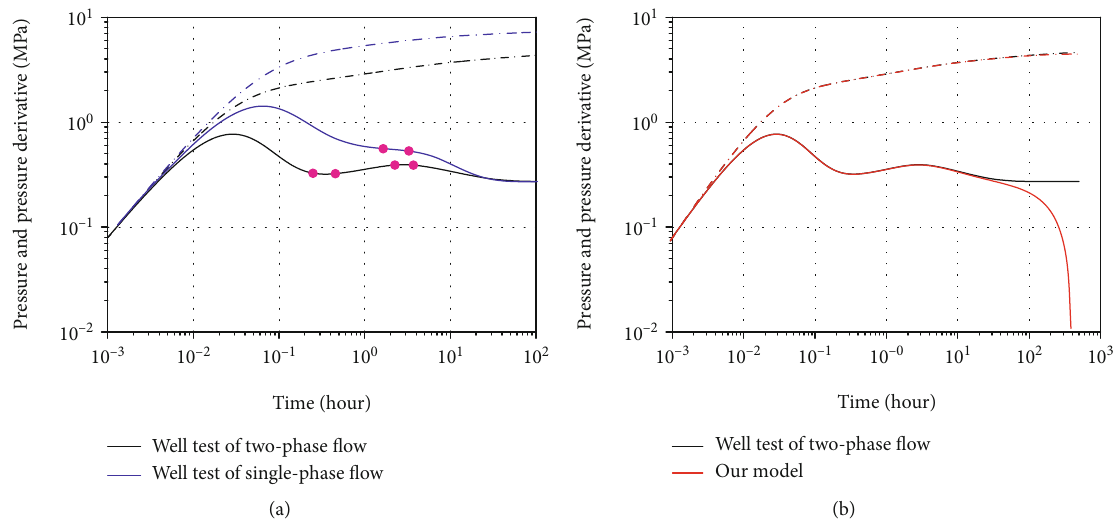
Figure 10: Comparison between our model and two traditional models. (a) Blue lines denote the pressure transient behaviors of a fallo ff test computed by a single-phase model in a single-well system. Black lines are the pressure transient behaviors of a fallo ff test computed by a two-phase model in a single-well system. (b) Red lines denote the pressure transient behaviors of a fallo ff test computed by our